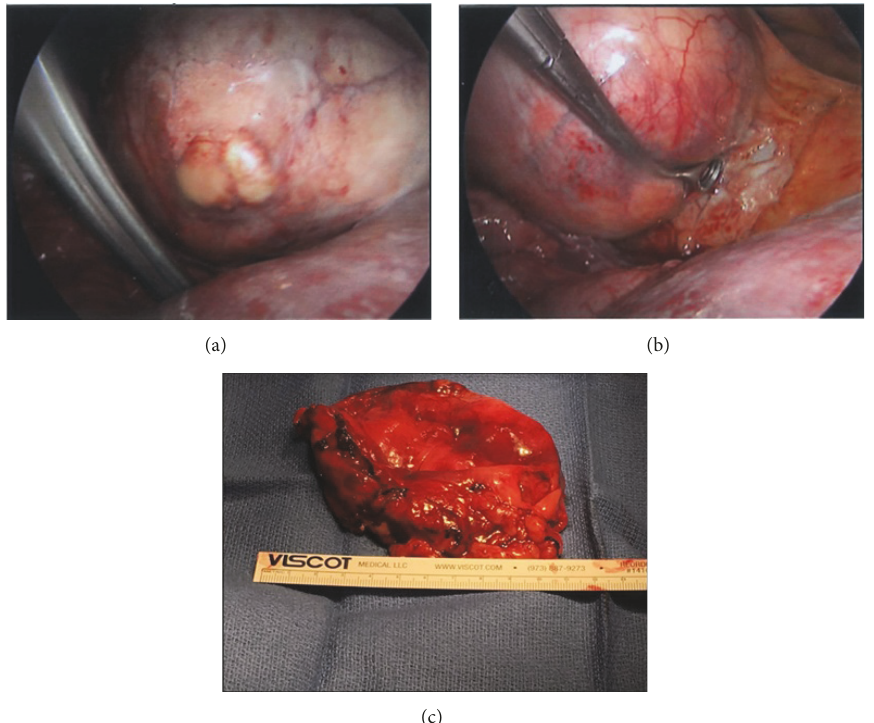
Figure 3: Intraoperative images show the pericardial cyst before (a and b) and after (c)